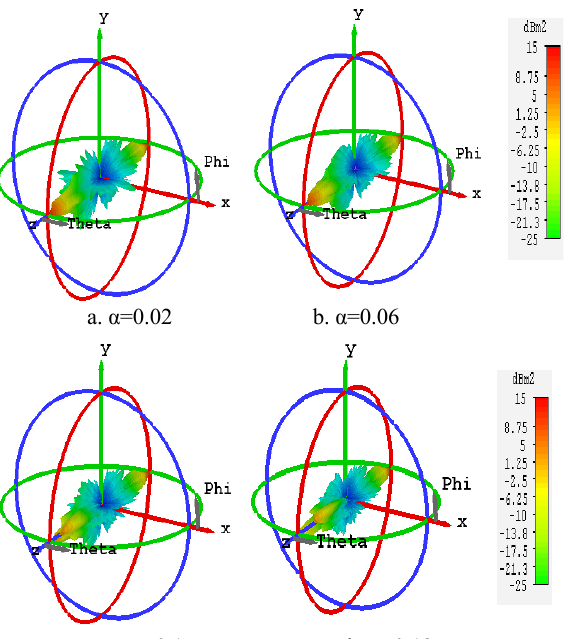
Fig. 10. The RCS variation versus angle for two dimension holes tapering off-diagonal with α=0.18, R o = 2.64 mm, and 11.75 GHz.